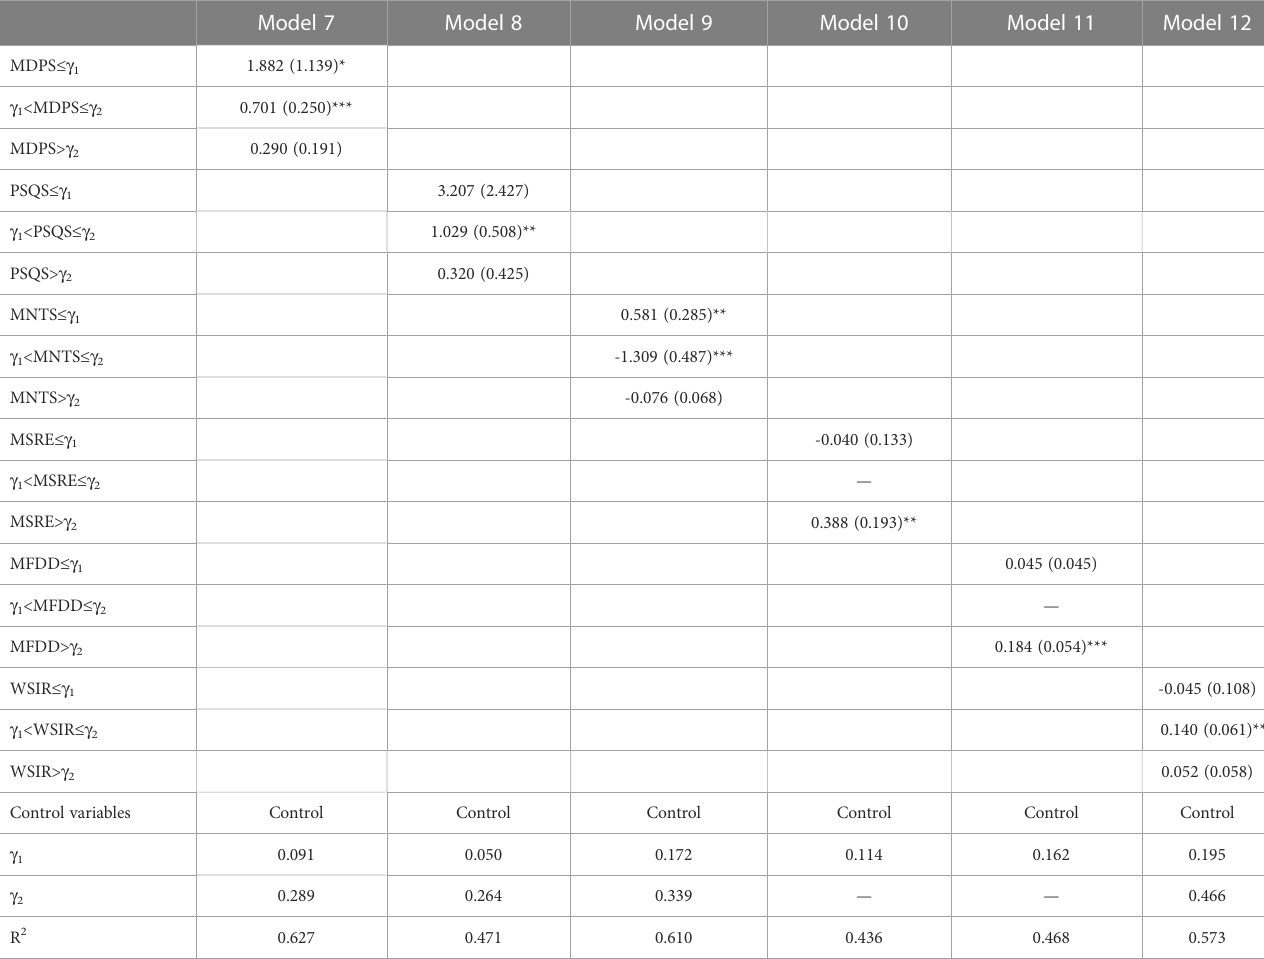
TABLE 2 The threshold model results of GTFPG in the major grain producing